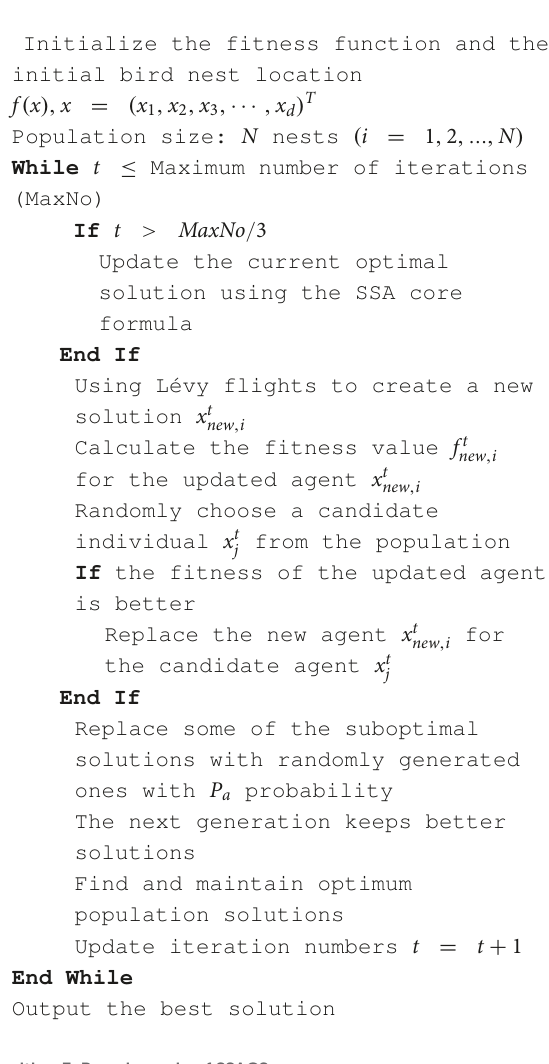
Algorithm 3. Pseudo-code of